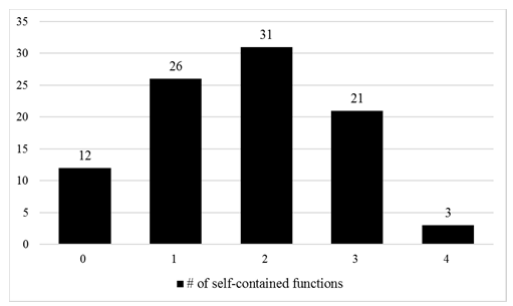
Figure 2. Frequency distribution of